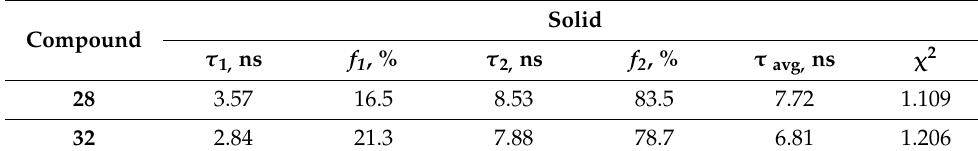
Table A2. Detailed data of the fluorescence lifetime measurements of 28 and 32 : τ —lifetime, f —fractional contribution, τ avg —average lifetime, and χ 2 —chi-squared distribution.